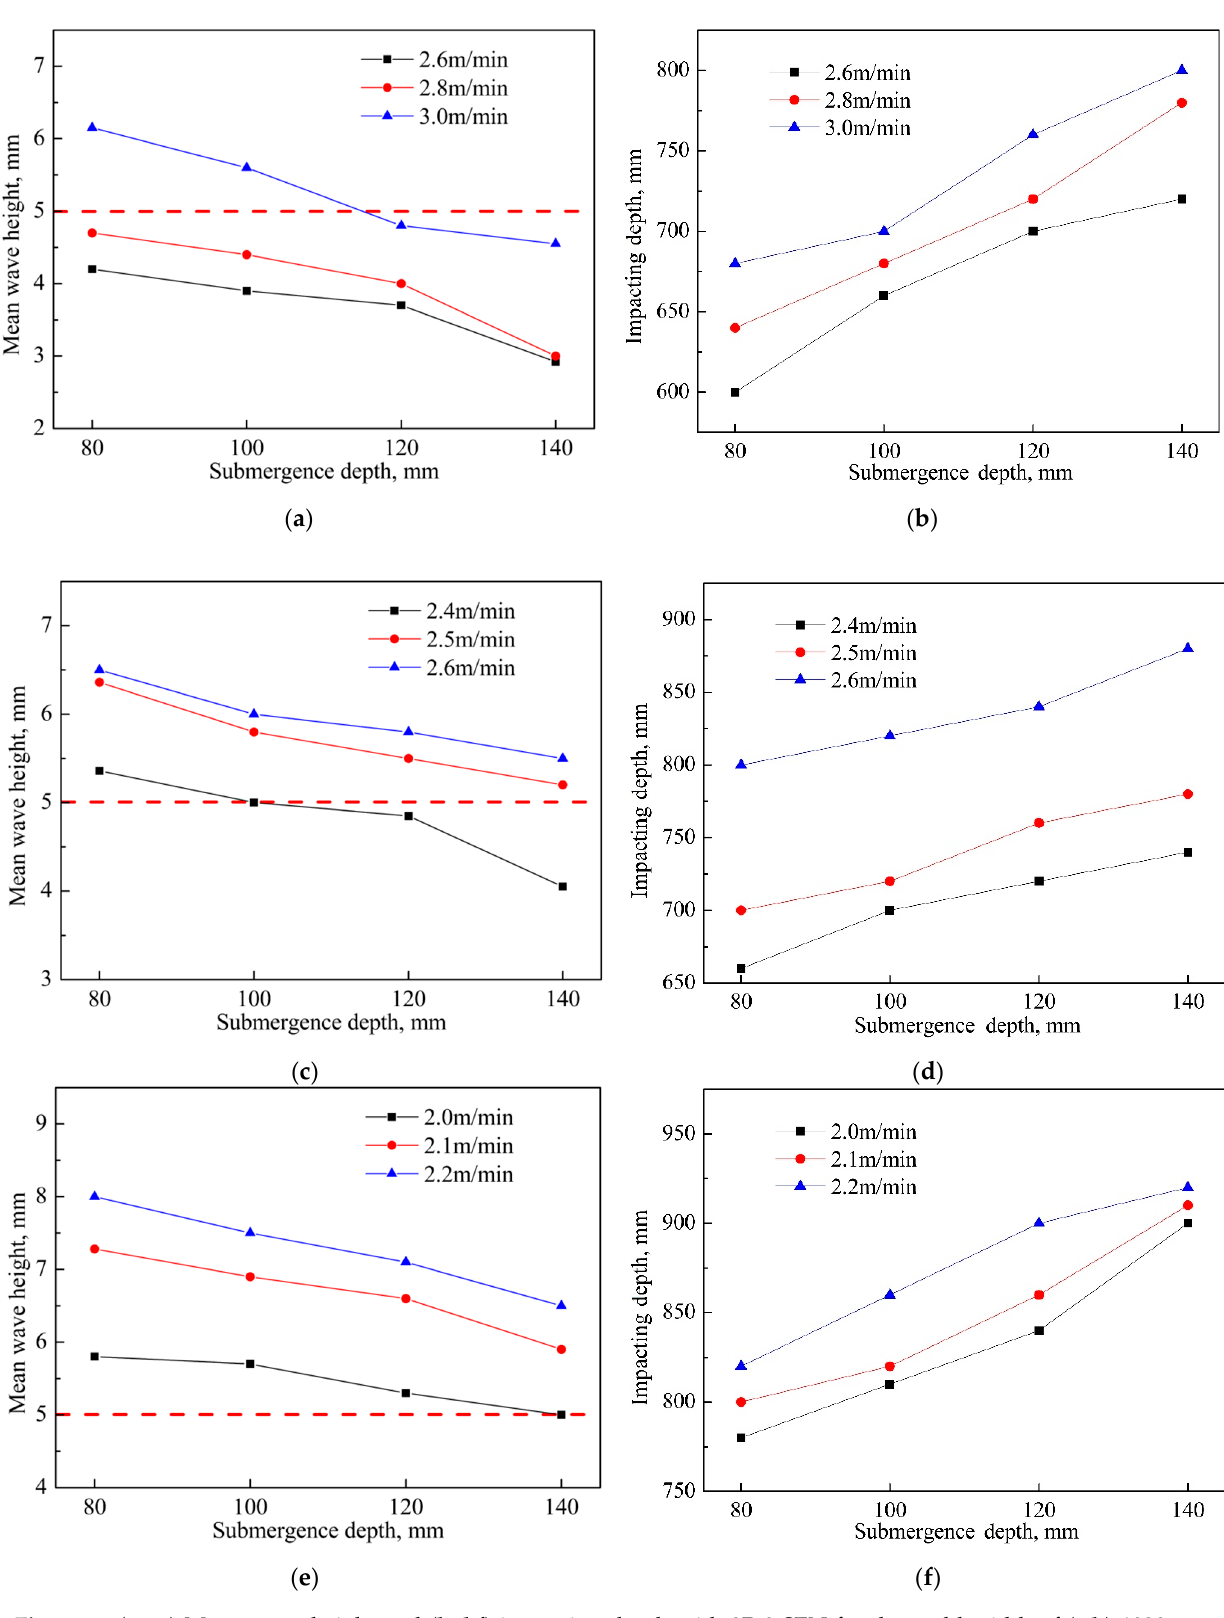
Figure 5. ( a , c , e ) Mean wave height and ( b , d , f ) impacting depth with 3P-0 SEN for the mold width of ( a , b ) 1020 mm, ( c , d )